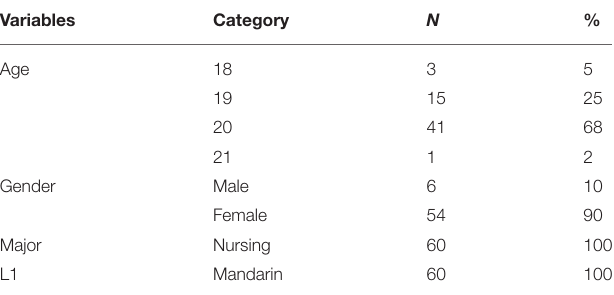
TABLE 2 | Demographic characteristics of the participating students ( n =